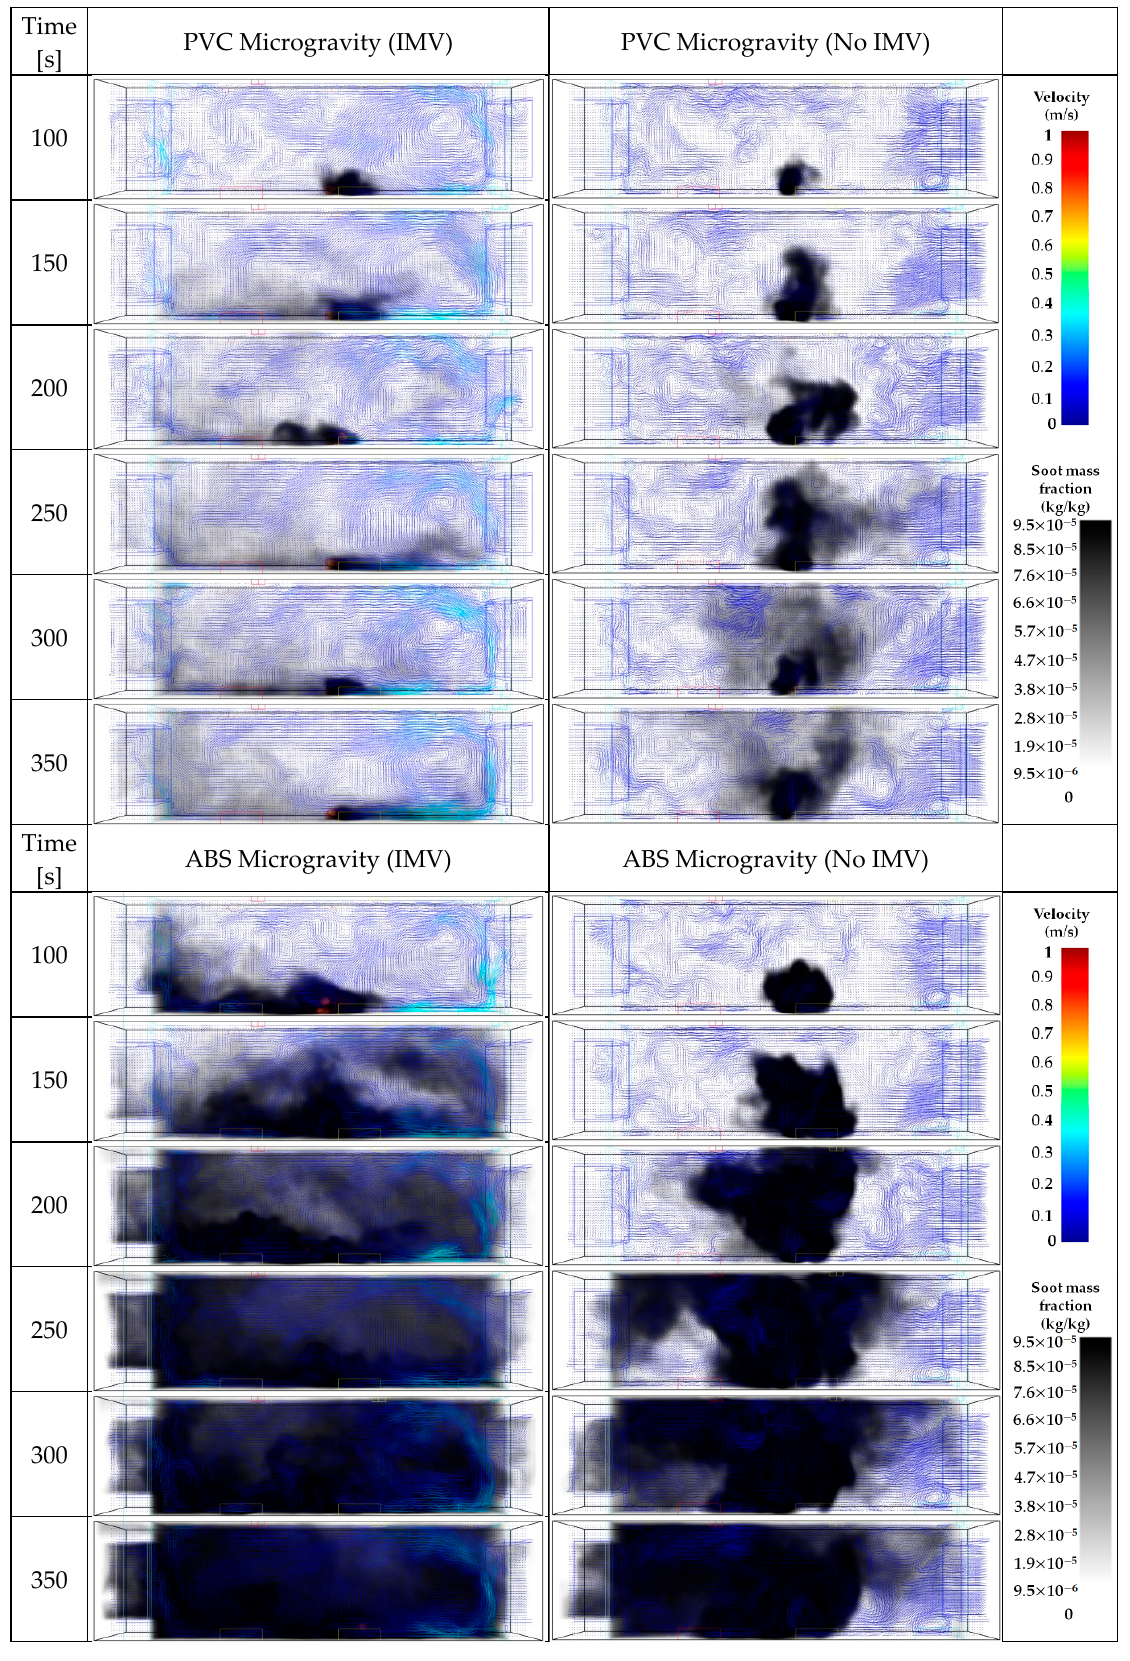
Figure 6. Smoke mass fraction with respect to time of PVC and ABS with and without IMV under microgravity.